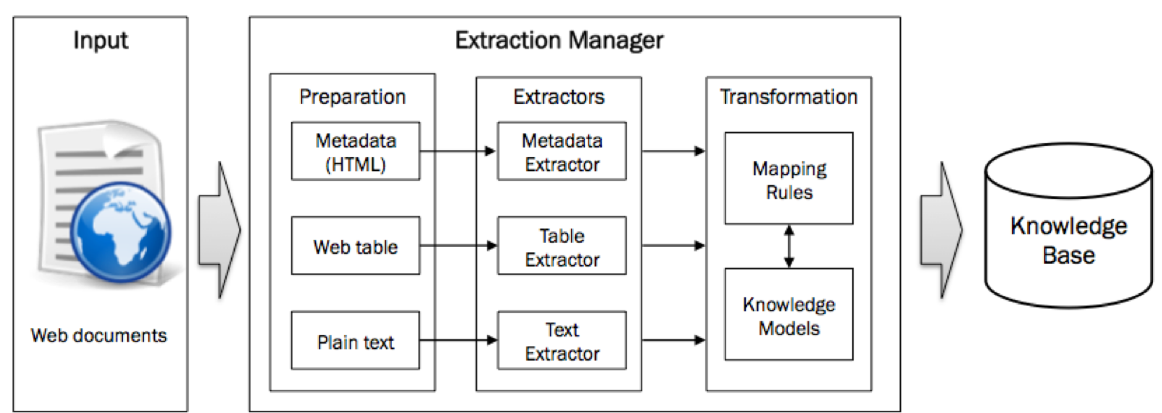
Figure 1 Architecture of the knowledge extraction framework